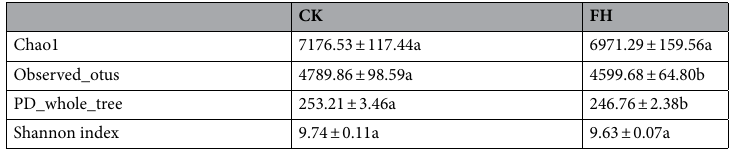
Table 3. Effects of Bacillus amyloliquefaciens FH-1 inoculation on rhizosphere bacterial alpha diversity. Values (means ± SD, n = 5) within the same row followed by different letters are significantly different at P < 0.05 according to Independent-Samples t Test. Chao1 richness of the Chao1 estimator, Observed_otus observed operational taxonomic units, Shannon index nonparametric Shannon diversity index, CK non-inoculated, FH inoculated with Bacillus amyloliquefaciens FH-1.